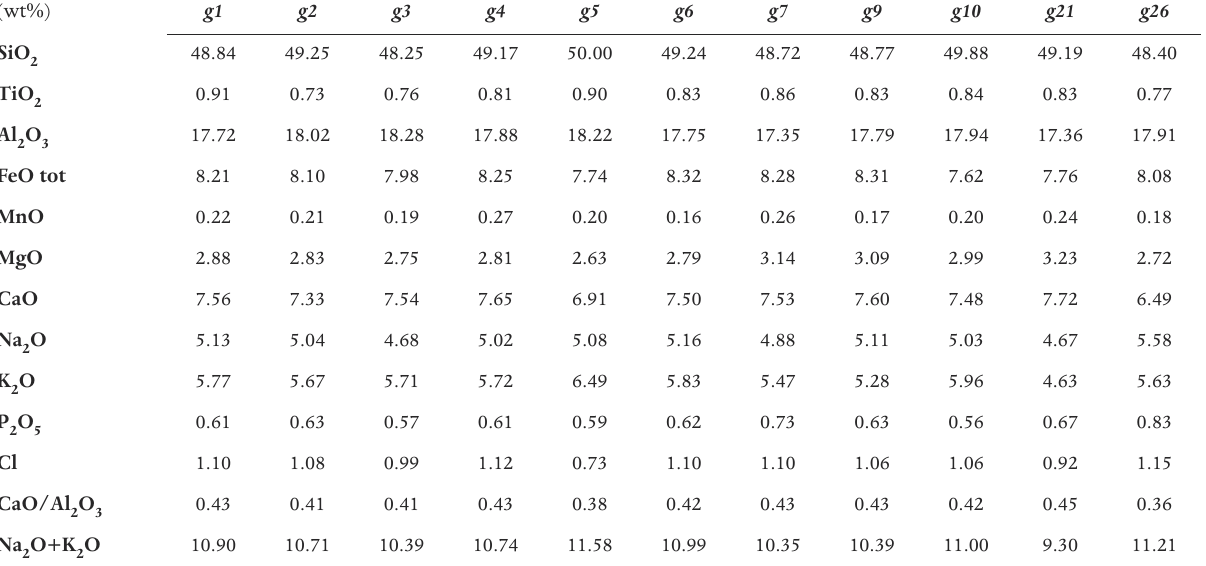
Table 5. Major element concentration in residual glasses of selected ash fragments belonged to the Unit B